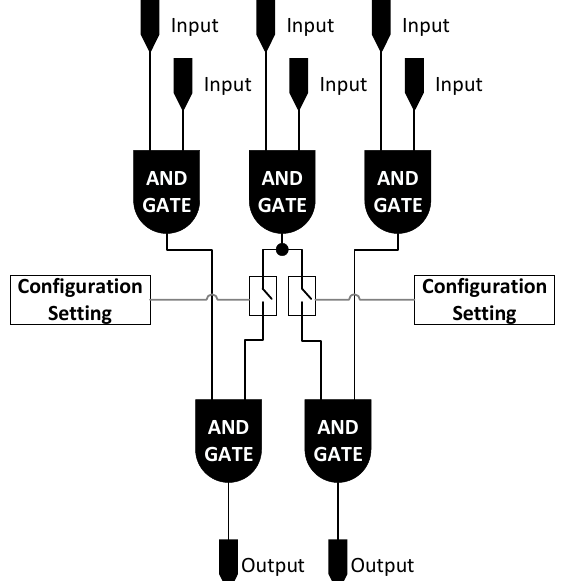
Figure 8. Depiction of how S/R components can be used to customize a highly connected AND-gate network to match a logical expert system network design.